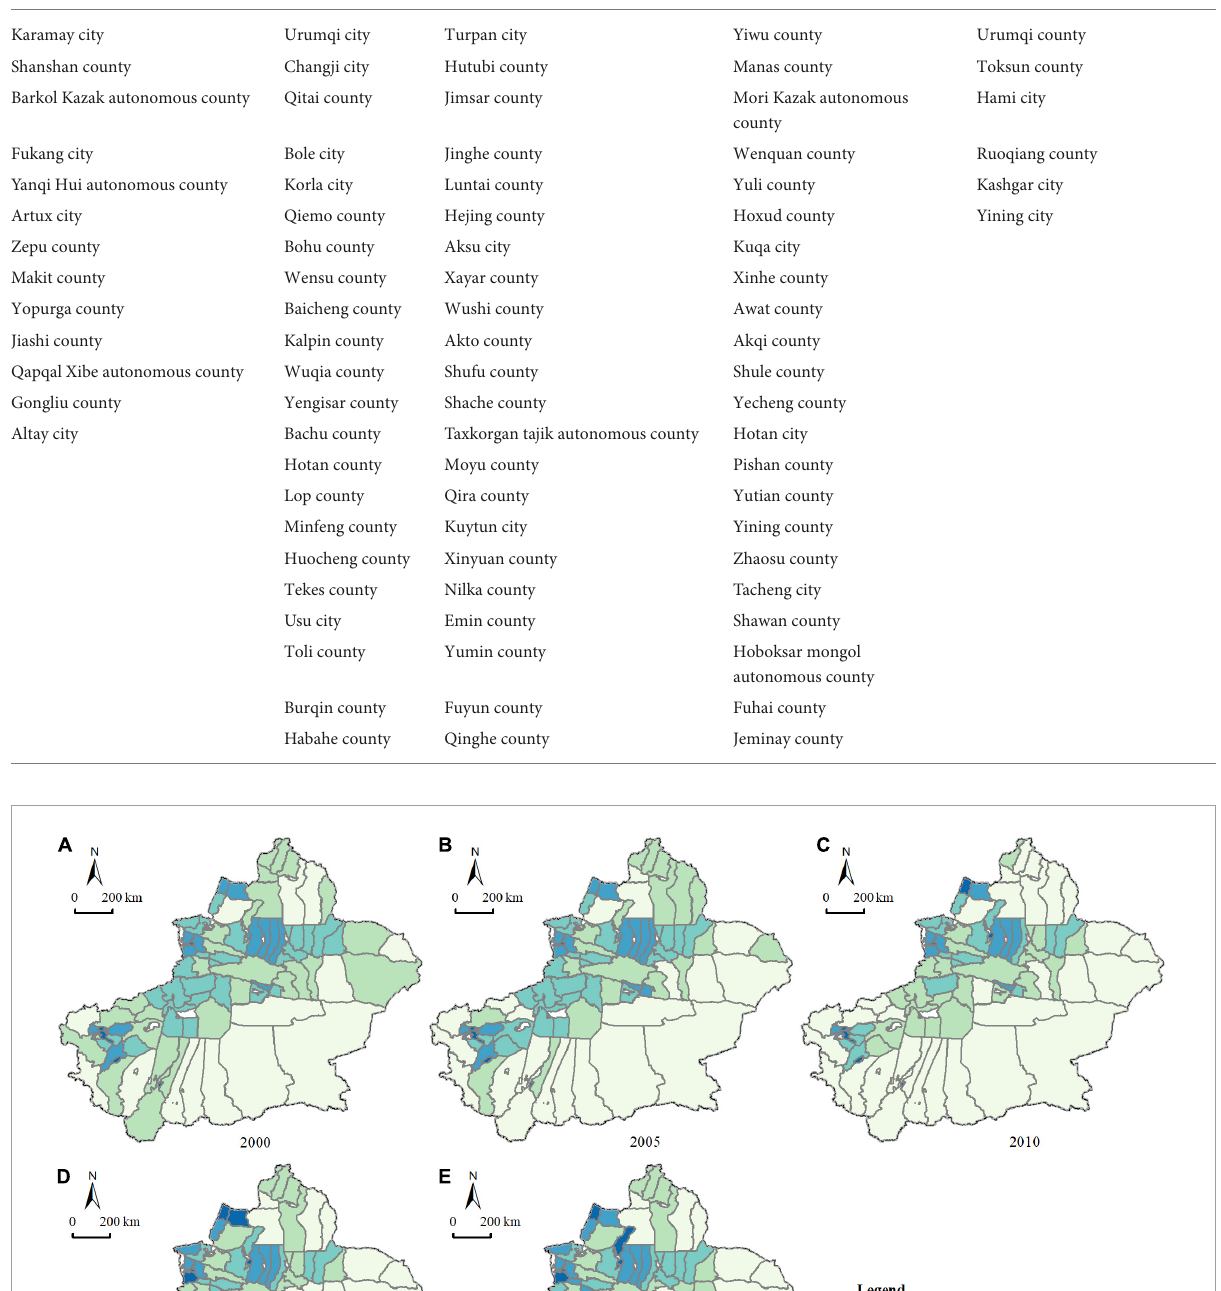
TABLE 3 Farmland use pattern indicator system.